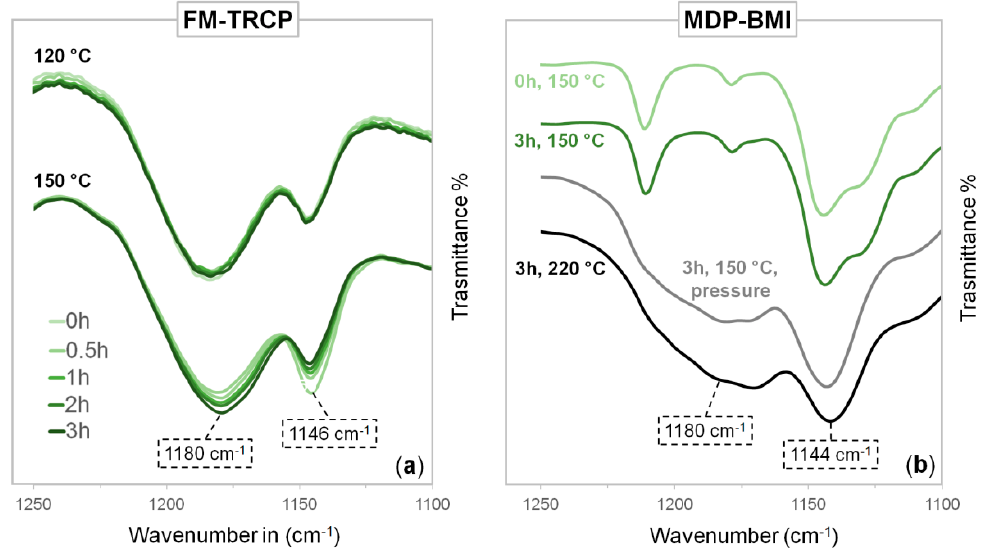
Figure 3. ( a ) FTIR measurements of the FM-TRCP over time at 120 and 150 °C. ( b ) FTIR measurements of MDP-BMI before and after 3 h at 150 °C, after being in a press for 3 h at 150 °C (4 MPa), and after 3 h at 220 °C.